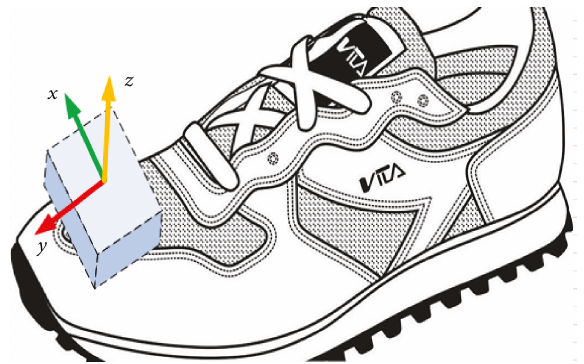
Figure 1: The IMU fi xed on the shoe.